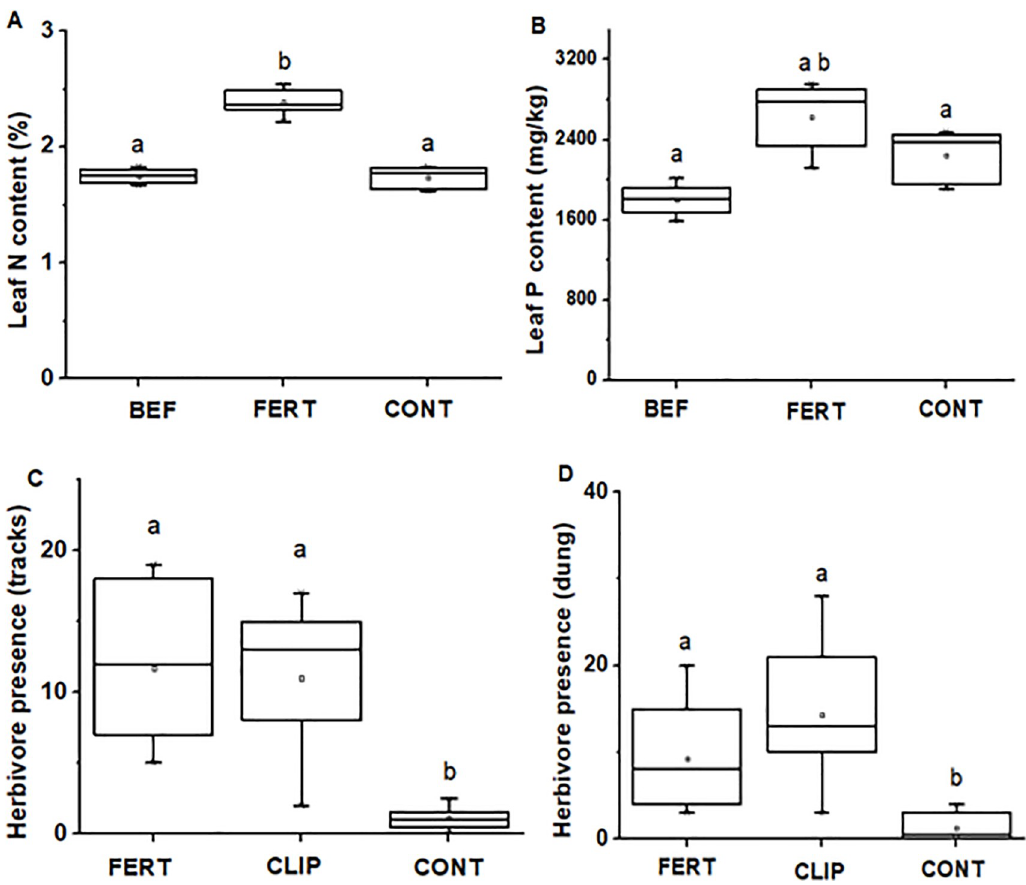
Fig 3. Grass leaf N contents (A) and P contents (B) before setting experimental plots (BEF), in fertilized plots (FERT) vs control (CONT) plots. Herbivore presence using average tracks (C) and dung (D) in fertilized (FERT), clipped (CLIP) and control plots (CONT). Boxplots show the mean (a square within boxes) and ranges from 25% and 75% quartile, and the tips of the whiskers indicate standard deviation. Boxes with different letter(s) are significantly different by Fisher LSD at P =